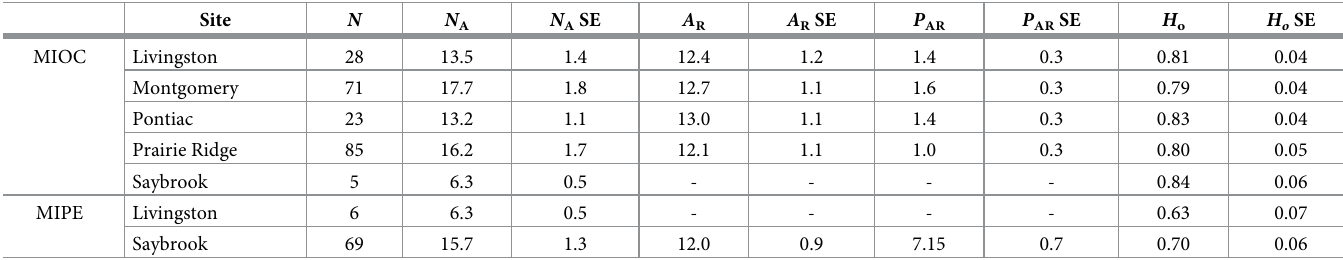
Table 2. Genetic diversity in 212 M . ochrogaster (MIOC) and 75 M . pennsylvanicus (MIPE) based on 15 microsatellite